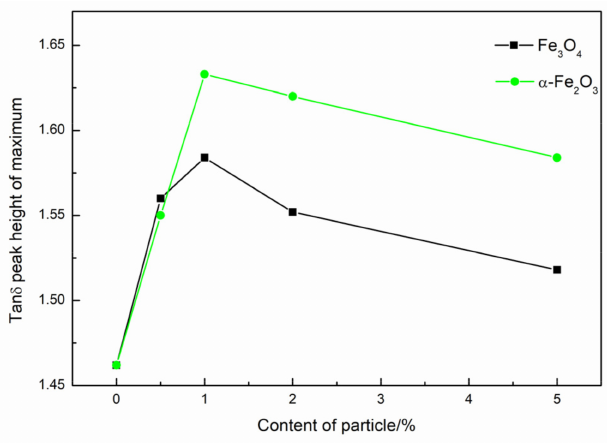
Figure 6. Effect of the content of inorganic particles on the peak height of PBMA blends.